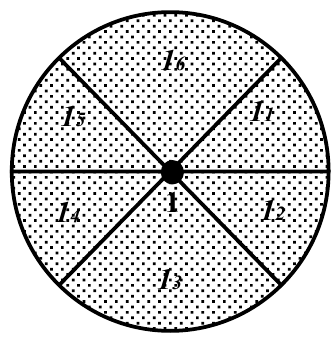
Figure 7. Transmission range of node